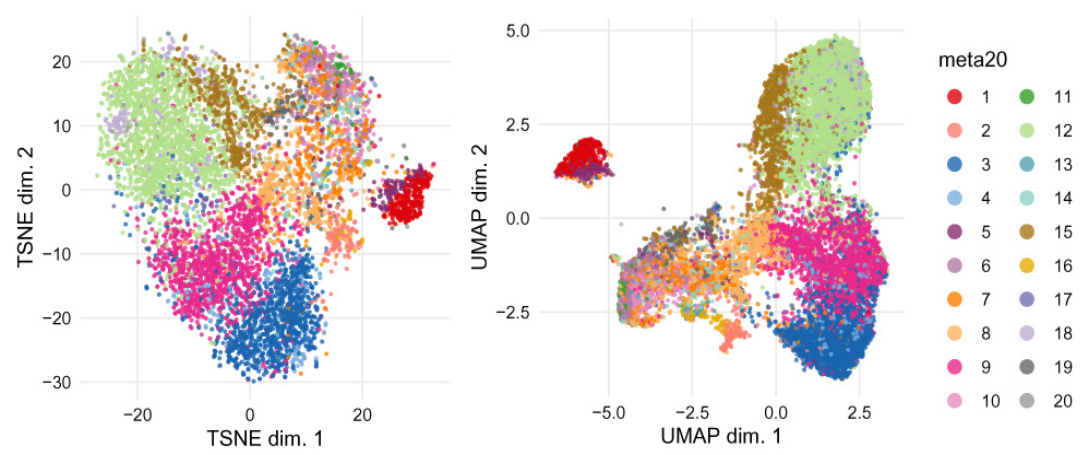
Figure 10. t-SNE and UMAP based on the arcsinh-transformed expression of the 10 lineage markers in the cells from the PBMC dataset. From each of the 16 samples, 500 (t-SNE) and 1000 (UMAP) cells were randomly selected. Cells are colored according to the 20 cell populations obtained with FlowSOM after the metaclustering step with ConsensusClusterPlus.